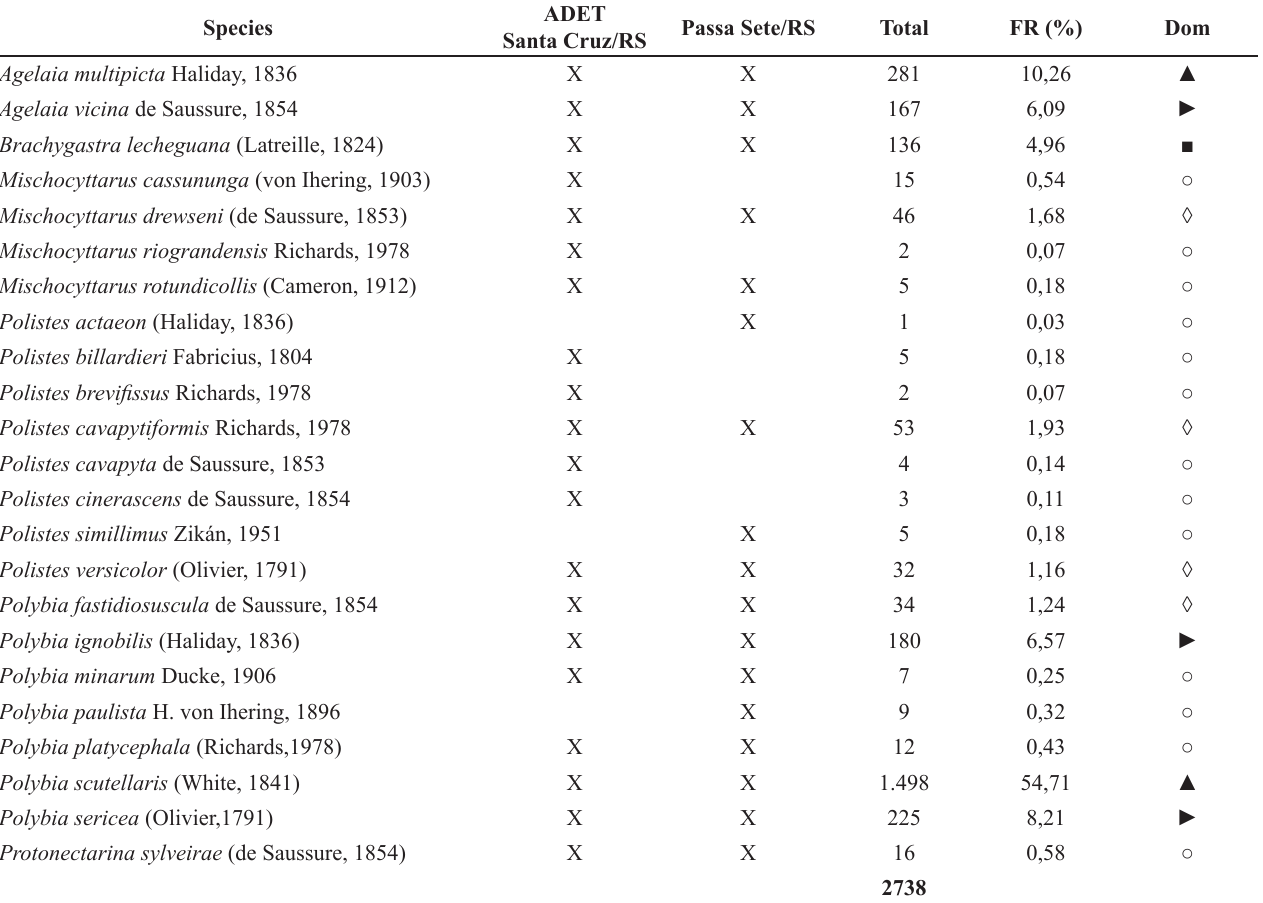
Table 1. Species of social wasps recorded for the farming of organic tobacco ( Nicotiana tabacum L.) at two different municipalities in Rio Grande do Sul state. FR = Relative Frequency; Dom = Dominance, classification: Eudominant (▲), Dominant (►), Subdominant (■), Recessive (◊), Rare